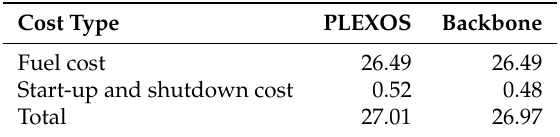
Table 2. Total fuel, start-up and shutdown cost results for each model ($ million). The solution tolerance was 0.1%, i.e., approximately $0.03